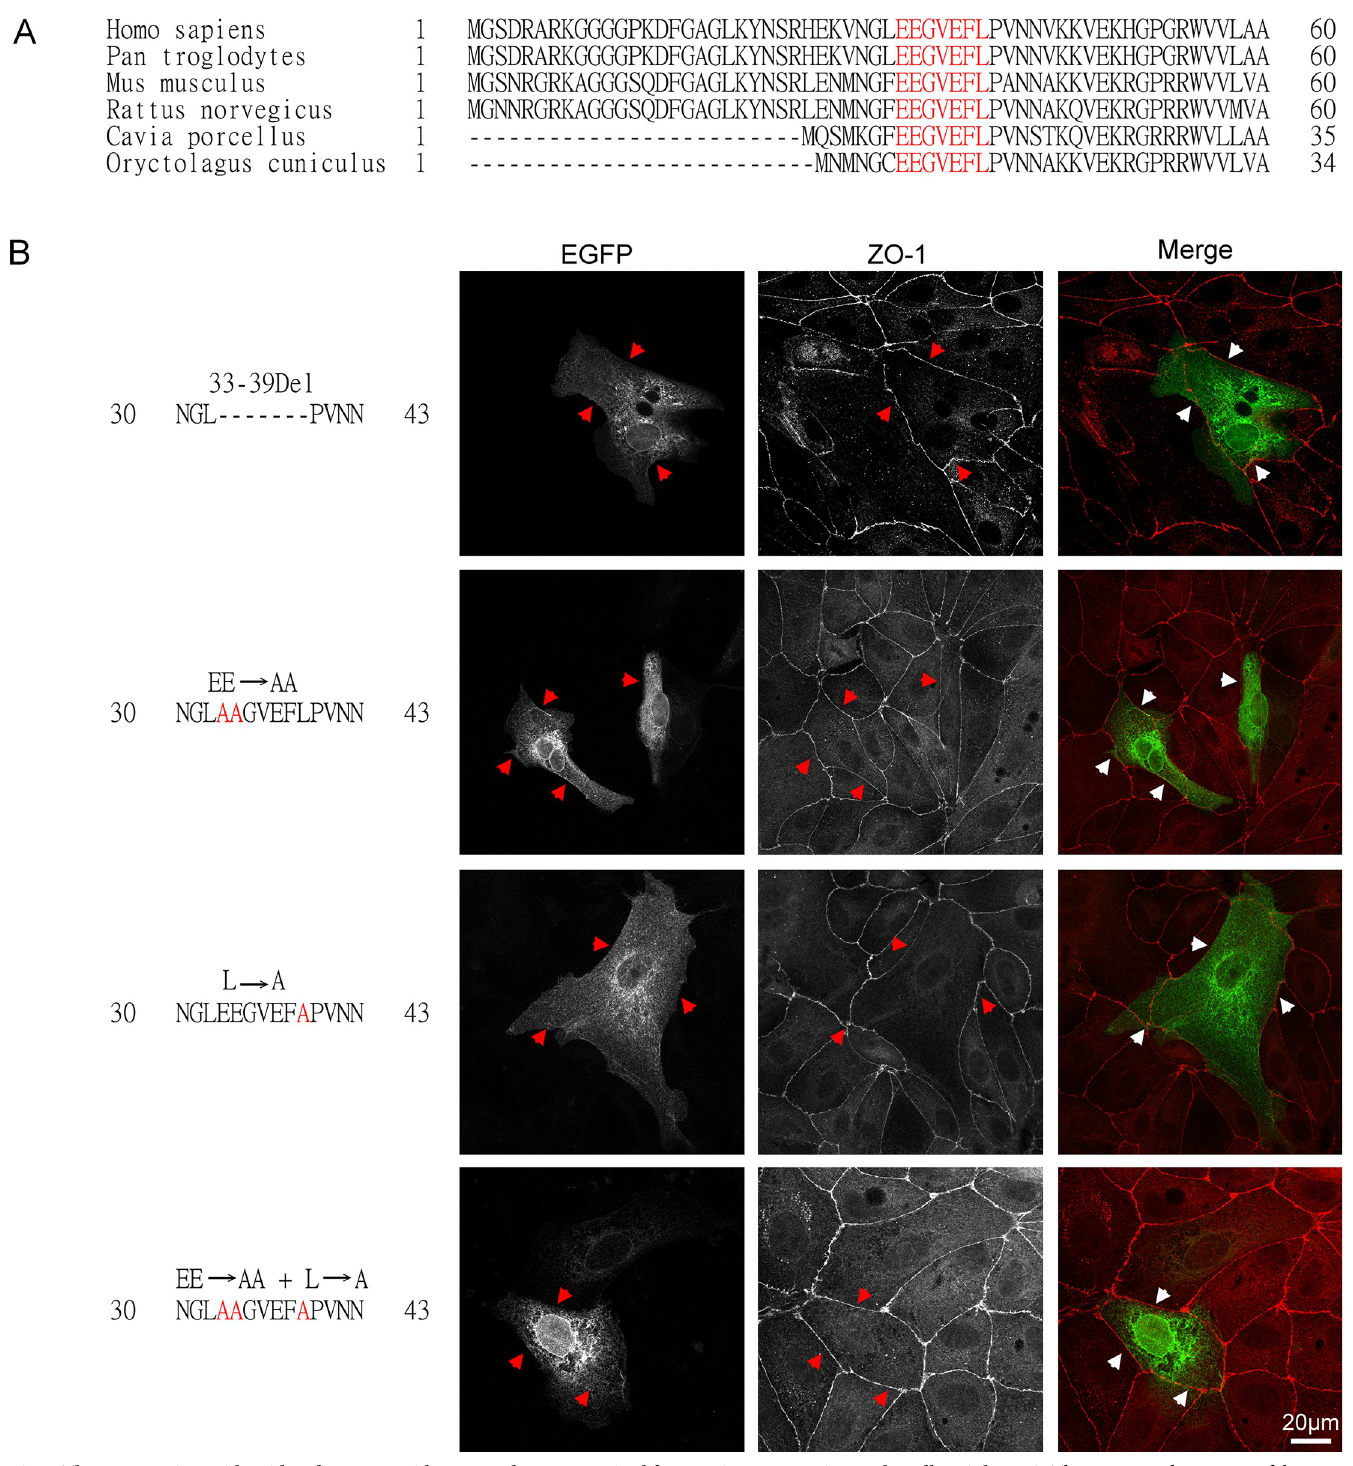
Fig 4. The seven amino acid residues between residues 33 and 39 are required for matriptase targeting to the cell periphery. A. The amino acid sequence of the matriptase cytoplasmic domain between residues 1 and 50 were compared among different species, including human (Homo sapiens), common chimpanzee (Pan troglodytes), house mouse (Mus musculus), common rat (Rattus norvegicus), guinea pig (Cavia porcellus), and rabbit (Oryctolagus cuniculus). The seven amino acid residues EEGVEFL (33–39 in human matriptase) are highlighted in red. B. The four mutated matriptase-EGFP constructs, including 33-39Del, EE ! AA, L ! A, and EE ! AA + L ! A, as indicated, were transiently expressed in MDCK cells. The subcellular localization of these matriptase-EGFP fusion proteins was compared with that